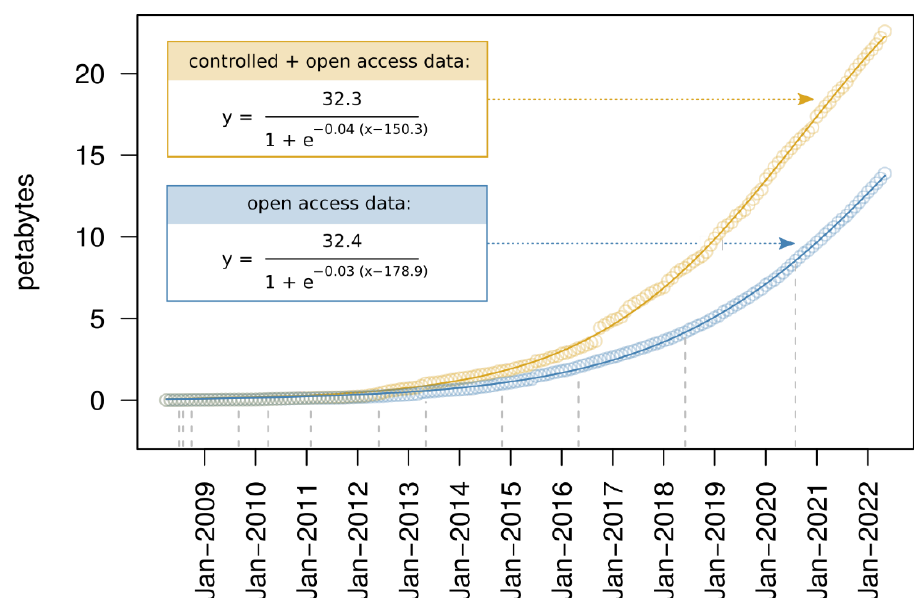
Figure 1. Size increase in the Sequence Read Archive. Shown is the cumulative amount of the total (yellow) and open access (blue) petabytes deposited in the SRA for each month between April 2008 and May 2022. The points represent the actual amounts and the solid lines show the nonlinear least squares fits of logistic functions that captured the trend of the nonlinear increase considerably better than exponential functions (not shown). Parameters of the fitted curves are detailed in the inlets. The dashed vertical lines indicate the time points at which the amount of open access data doubled relative to the previous doubling time point.